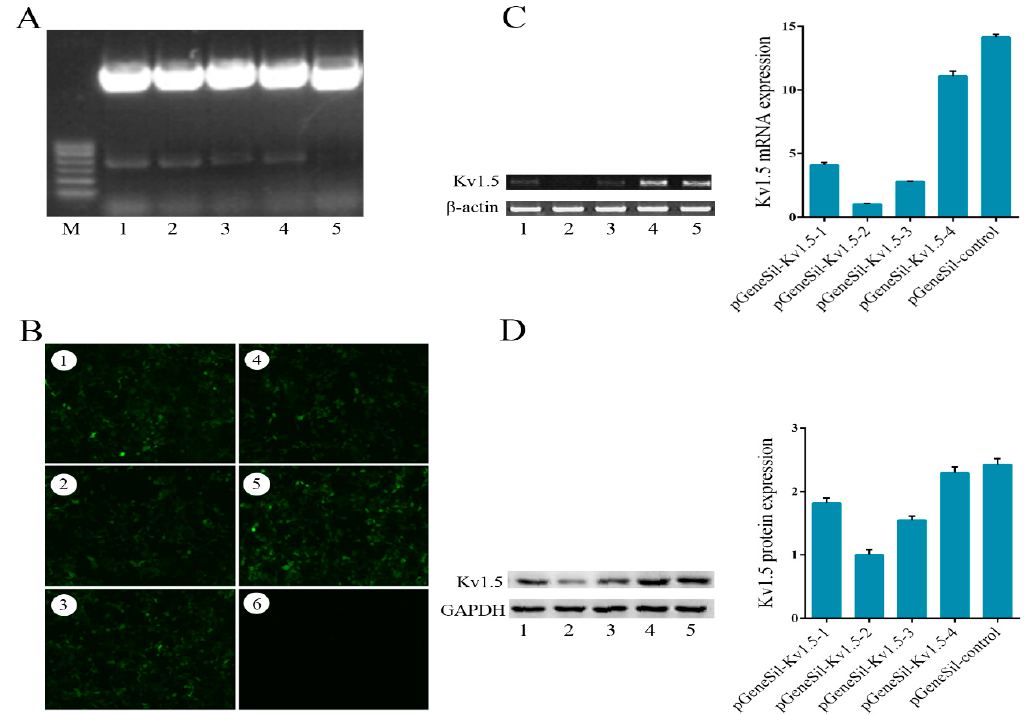
Figure 2. Screening, identification, transfection and evaluation of Kv1.5 shRNA. ( A ) Plasmid DNA was cut by HindIII and SalI. M: DNA marker. 1: pGeneSil-Kv1.5-1; 2: pGeneSil-Kv1.5-2; 3: pGeneSil- Kv1.5-3; 4: pGeneSil- Kv1.5-4; 5 : pGeneSil-control; ( B ) The images of MG-63 cells after transient transfection with 1: pGeneSil-Kv1.5-1; 2: pGeneSil-Kv1.5-2; 3: pGeneSil-Kv1.5-3;